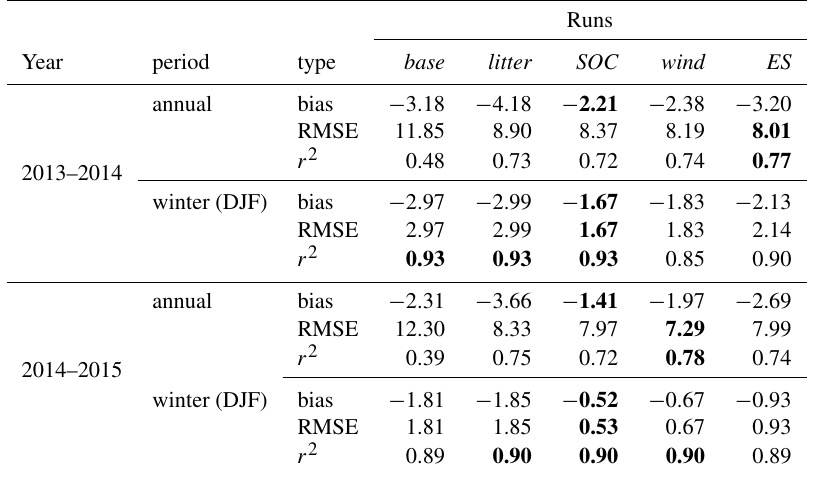
Table 3. Statistical indicators of the differences between observations and model results of the soil volumetric water content (%) at − 15cm on a 6h time step. Bold values indicate the best